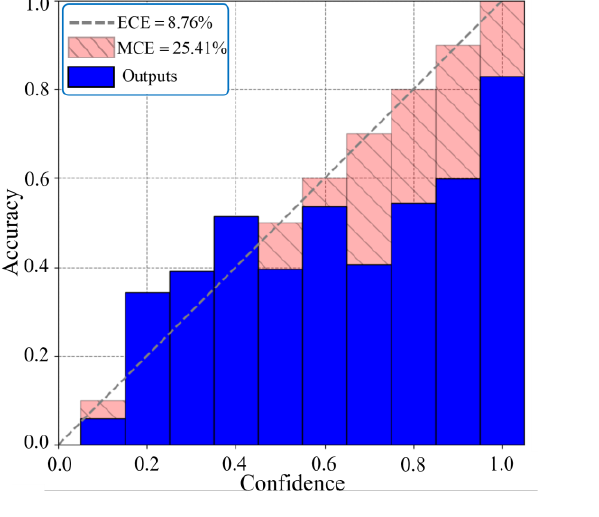
Figure 3. The learning process of the temperature scaling factor. ( a ) Loss in learning process; ( b ) The temperature scaling factor in learning process.